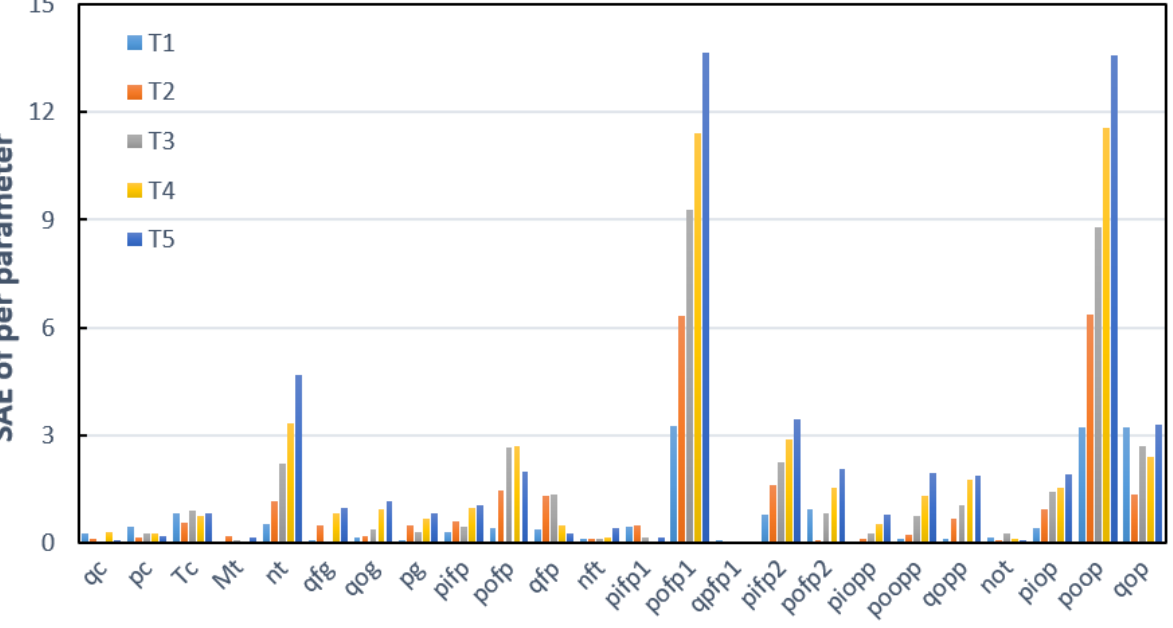
Figure 8. SAE of five consecutive samples after injection fault of test 11.